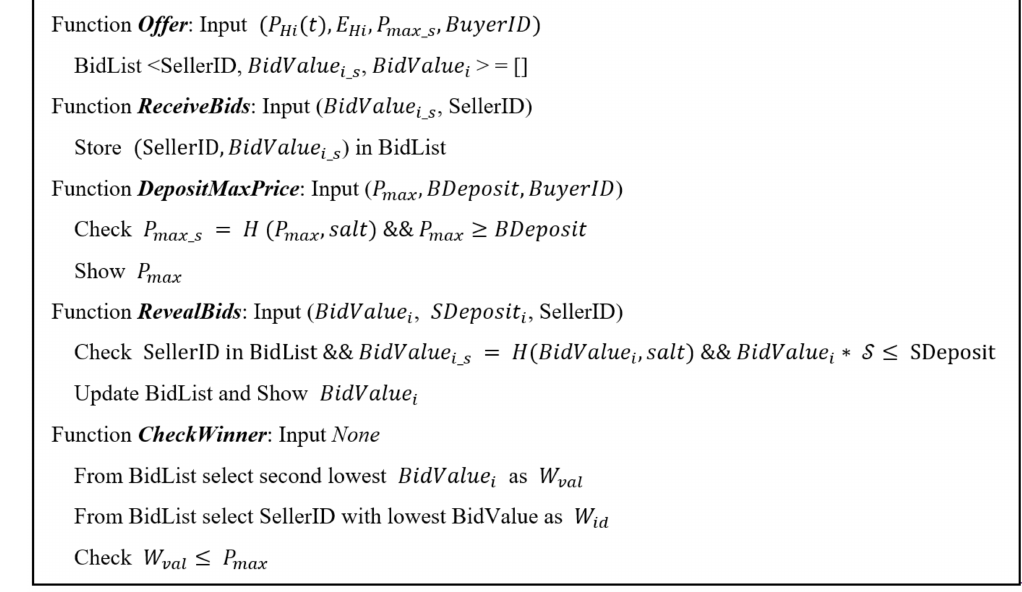
Figure 5. Negotiation algorithm for resource